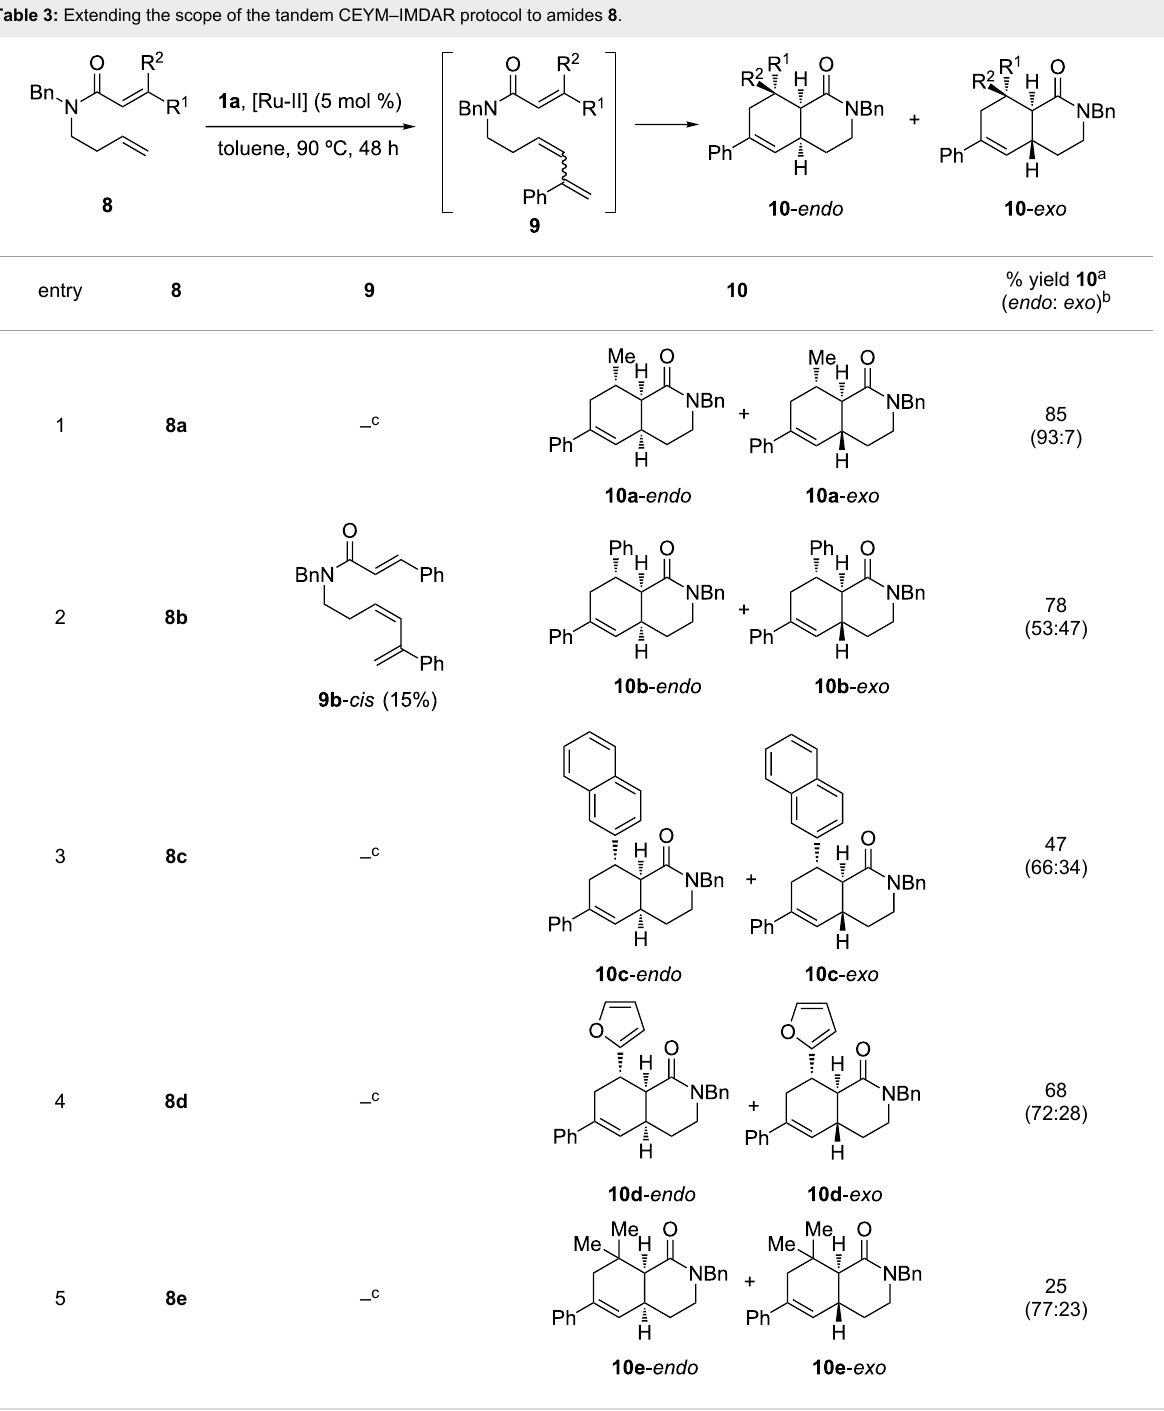
Table 3: Extending the scope of the tandem CEYM–IMDAR protocol to amides 8